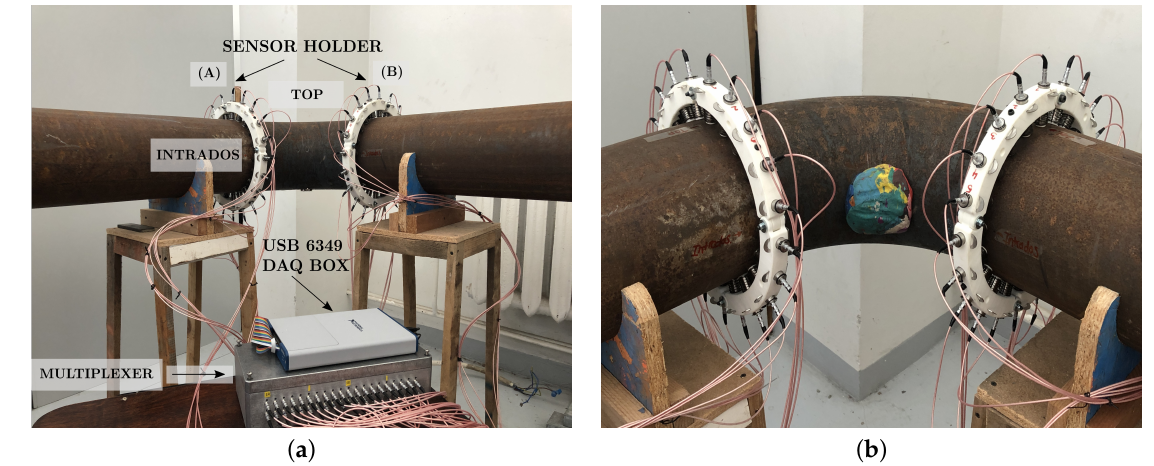
Figure 8. ( a ) Steel pipe bend specimen with the same characteristics as in Table 1. Measurement setup with transducer arrays A and B with 20 transducers each and an acquisition system; ( b ) pipe bend with an artificial defect composed of plasticine and located on the intrados position, intrados